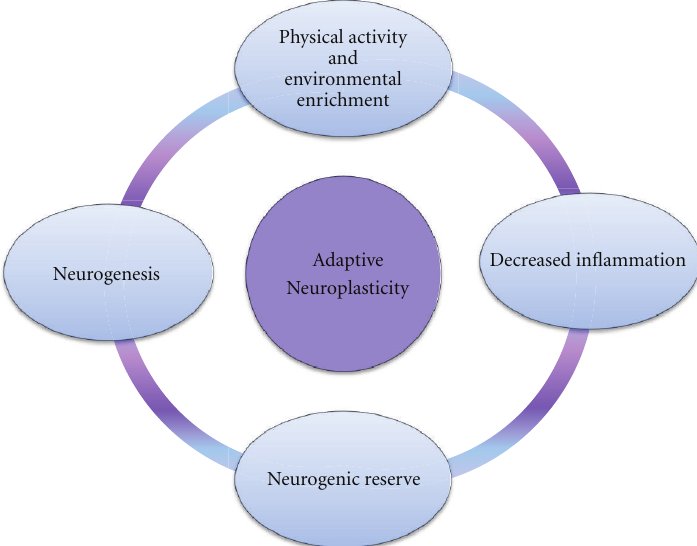
Figure 2: The Cycle of Adaptive Neuroplasticity.